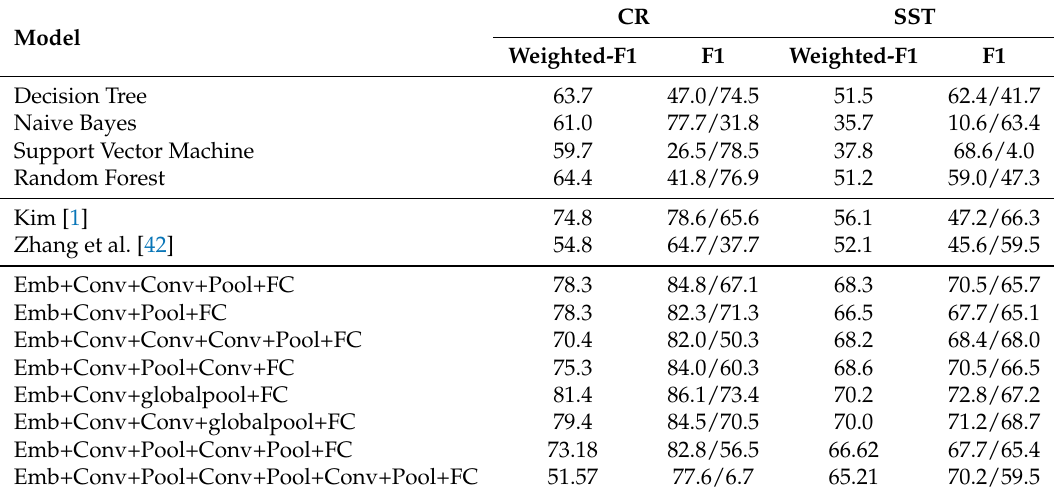
Table 4. The results with the CR and SST data, where Emb, Conv, Pool, globalpool, FC stand for embedding layer, convolutional layer, pooling layer, global pooling layer, and fully-connected layer,